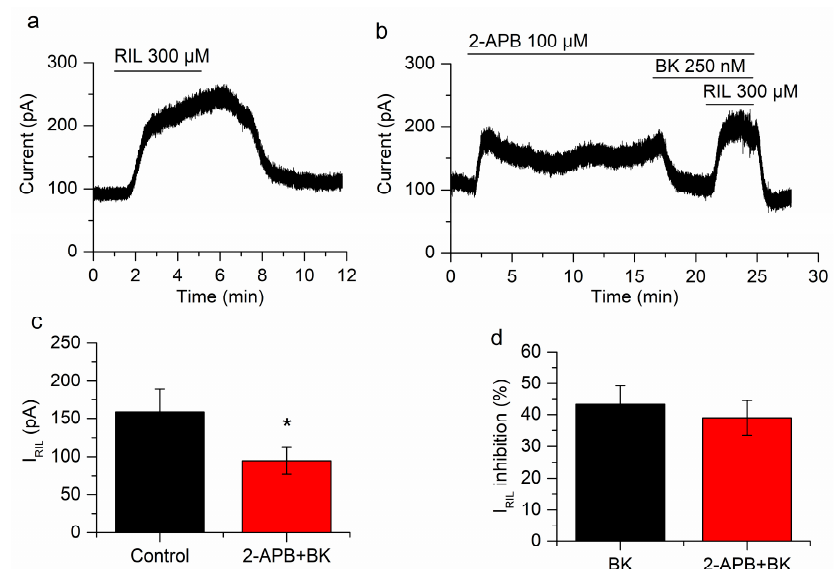
Figure 7. Ca 2+ release does not play a role in the inhibition of I RIL by BK. ( a ) I RIL in control conditions. ( b ) Application of 2-aminoethoxydiphenylborane (2-APB) provokes an outward current at − 30 mV and the inhibition of I RIL by BK is not affected in the presence of this drug. ( c ) The difference between I RIL control (black bar) and I RIL in presence of BK and 2-APB (red bar) is significant ( p = 0.029; n = 5). ( d ) The percentages of BK inhibition in absence (black bar) and presence of 2-APB (red bar) are similar ( p = 0.79). Recordings in ( a , b ) belong to the same neuron. * p < 0.05.